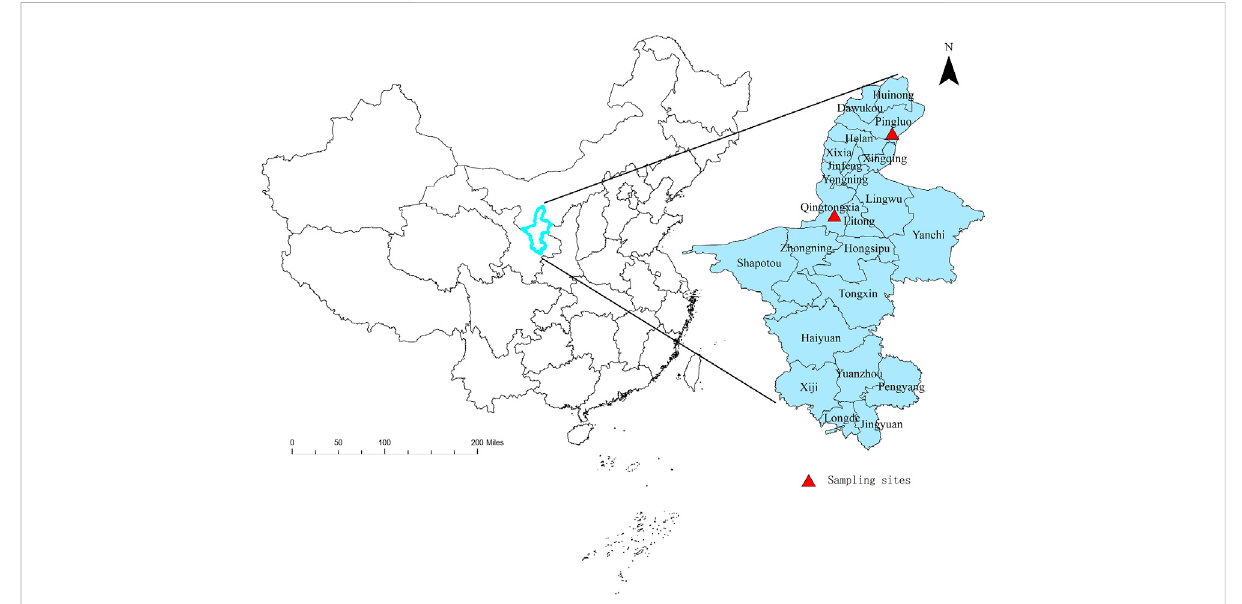
FIGURE 1 Location of sampling sites in the China Northwest Cohort-Ningxia Project